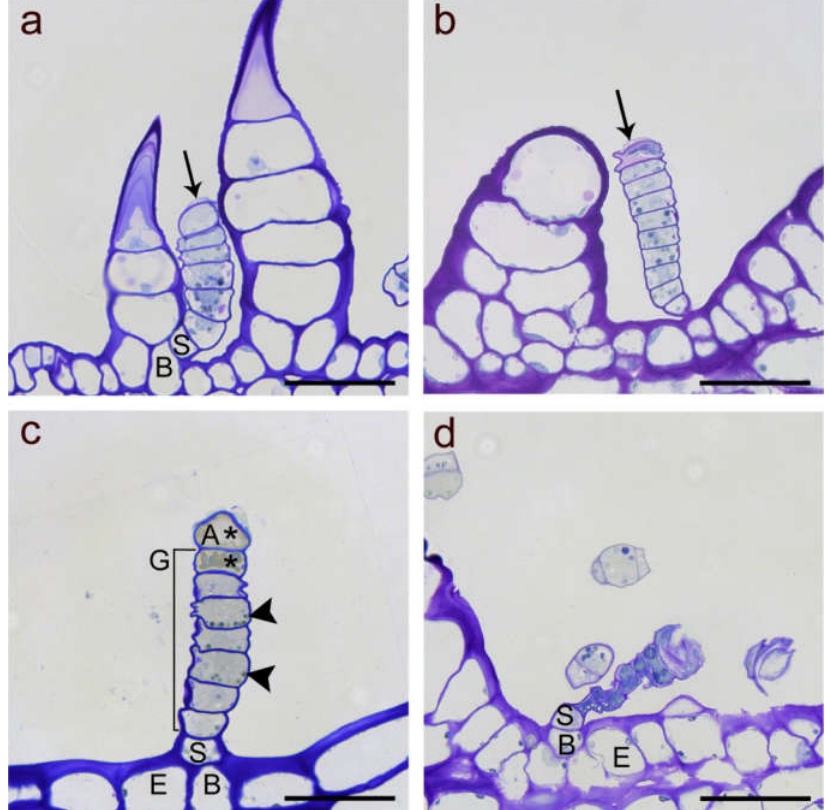
Figure 2. Light microscope images of linear glandular trichomes from phyllaries ( a , d ) and leave veins ( b , c ) in different developmental stages stained with Toluidine Blue O. ( a ) Early stage of a biosynthetically active LGT (between two nonglandular trichomes) showing strong vacuolization in the basal (B) and stalk cells (S), followed by five glandular cells rich in plasma and organelles and the apical cell starting with formation of a subcuticular cavity (black arrow). ( b ) Advanced stage of a biosynthetic activity LGT as indicated by progressed separation of the cuticle and extracellular storage of metabolites at the tip (black arrow). The apical cell had started degeneration and the wall partly collapsed. ( c ) Deposition of metabolites and cell degeneration (marked by stars) in the apical cell (A) and the adjacent glandular cell (G) while lower glandular cells still showed intact plastids (black arrowheads). The stalk cell showed thick lateral cell walls. ( d ) Senescent, degenerated trichome of the post-secretory stage with collapsed glandular cells but still vital stalk (S) and basal (B) cell in the epidermis (E). Scale bar = 50 µm.